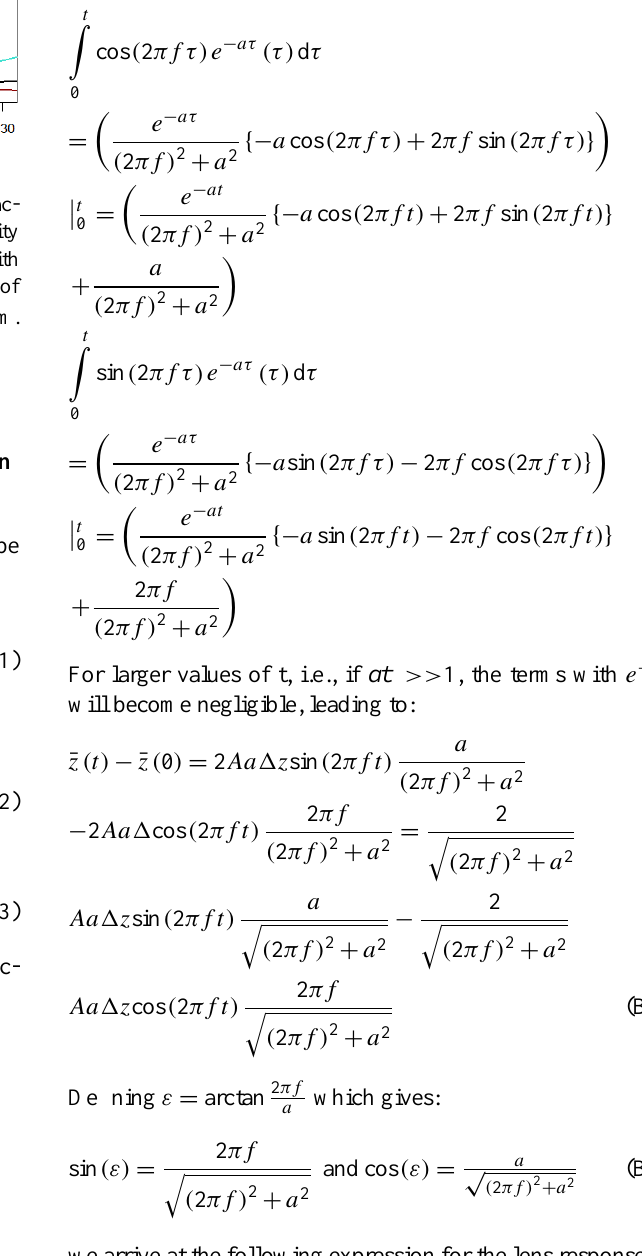
Figure 12: Figure AI1: